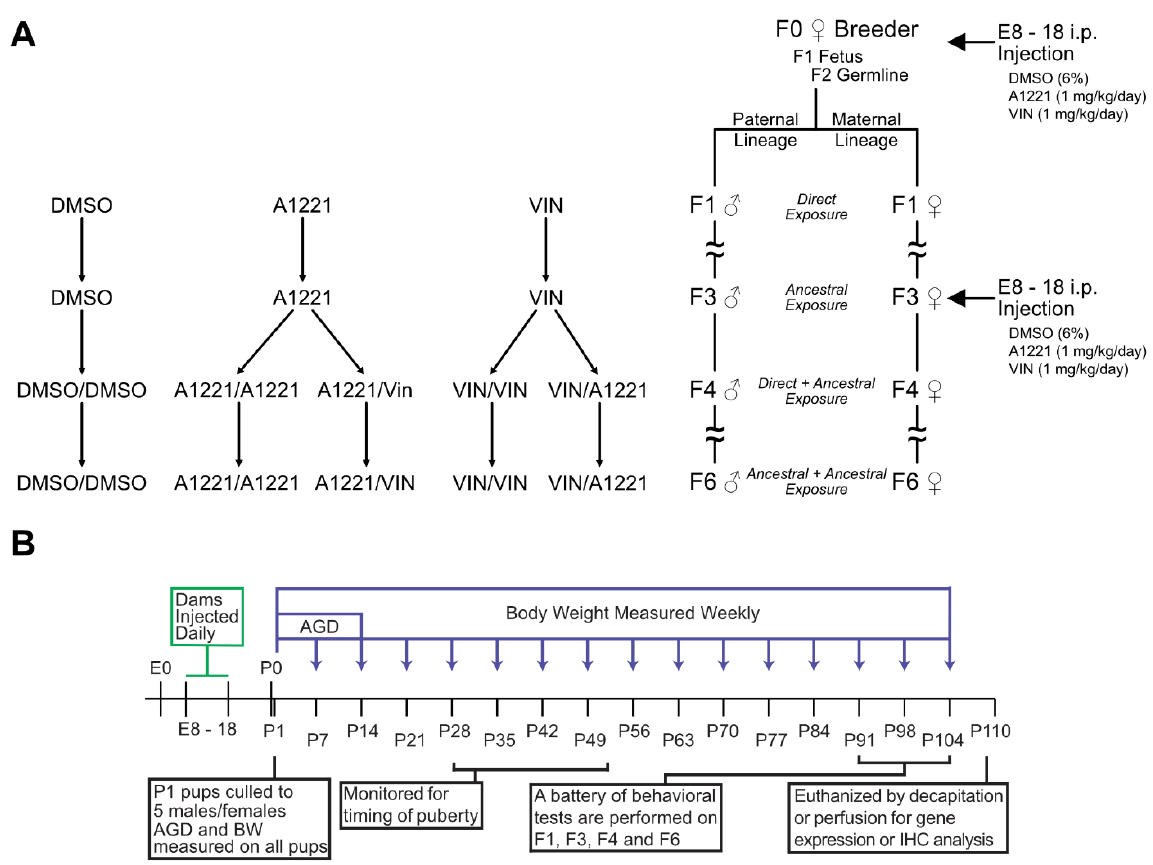
Figure 1. Experimental design and timeline. The experimental design is shown ( A ) including parental lineages, generations, and treatment groups used for analysis. EDC exposure was administered via i.p. injection to F0 and F3 pregnant dams from E8-18. The timeline ( B ) indicates all experimental manipulations and measurements taken. AGD: anogenital distance.